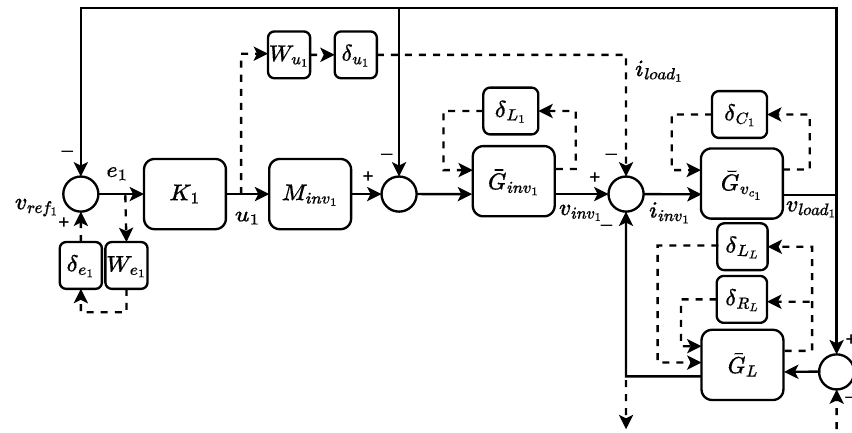
Figure 4. Extended block diagram of the first subsystem in Figure